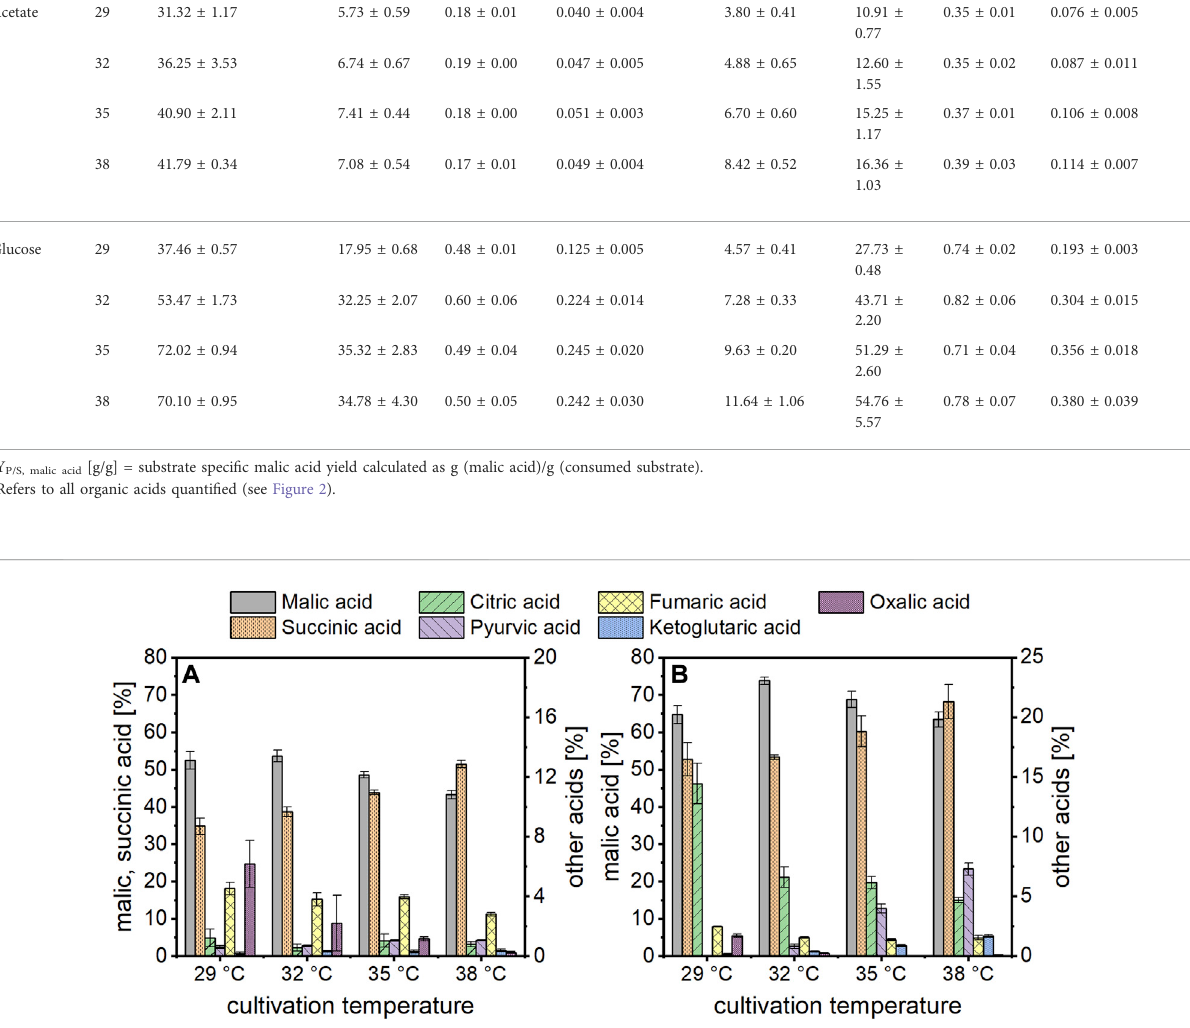
FIGURE 2 Organic acid composition obtained after 144 h of cultivation at different temperatures with acetate (A) or glucose (B) as carbon source. In (A) theleftaxiscoversthemalateandsuccinatepercentages,whiletherightaxisdisplaysthedatafortheotherproducts.In (B) ,theleftaxispresentsonly themalicacidpercentages,whiletherightaxiscoversallsideproducts,includingsuccinate. Datapointsrepresentmeans±standarddeviation, n